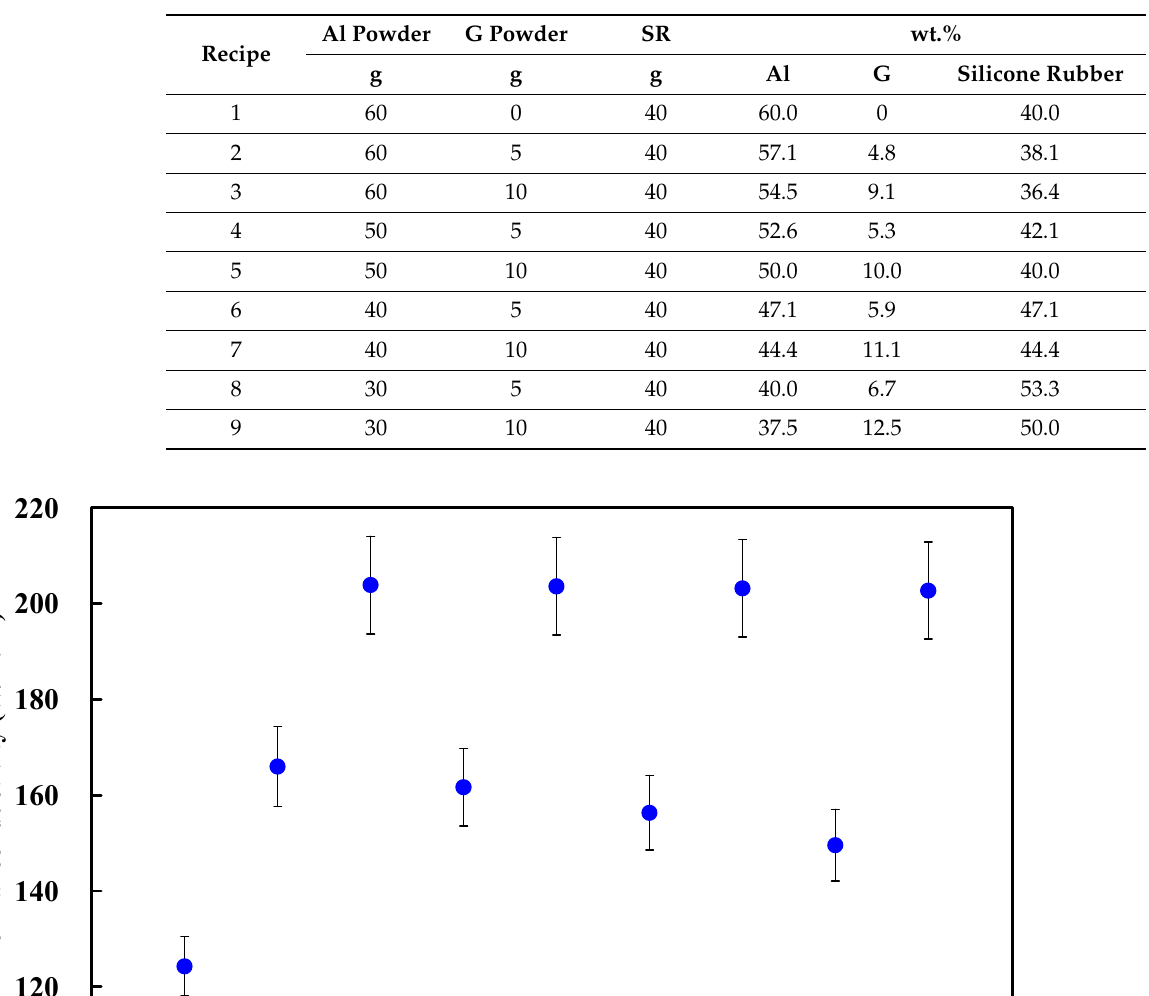
Table 1. Planning table for silicon rubber adding different weight ratios of Al powder and G powder.